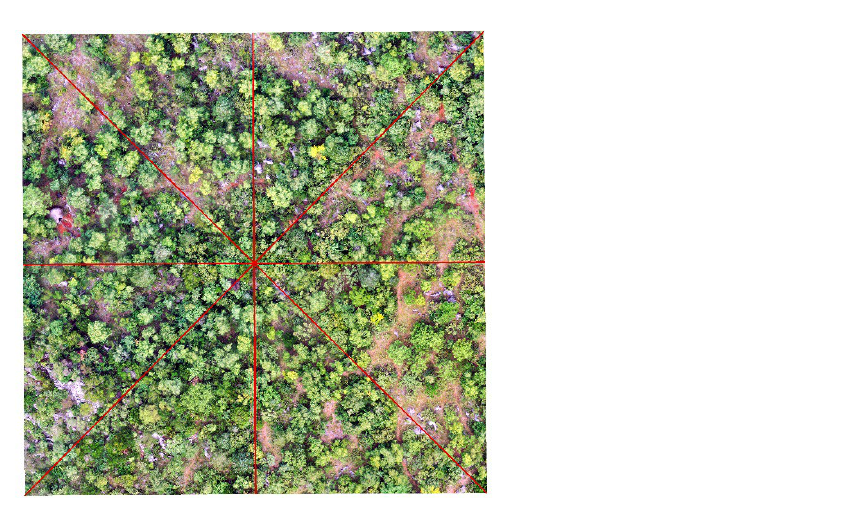
Figure A1. Photos of real scene. ( a ) Karst clints outside the tiankeng; ( b ) Karst land outside the tiankeng; ( c ) Shenxiantang tiankeng photo; ( d ) Acquire ground control points with RTK; ( e ) Ground control point marking photo.